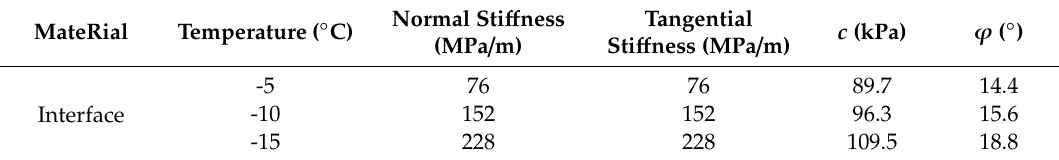
Table 7. Parameters of the interface at three